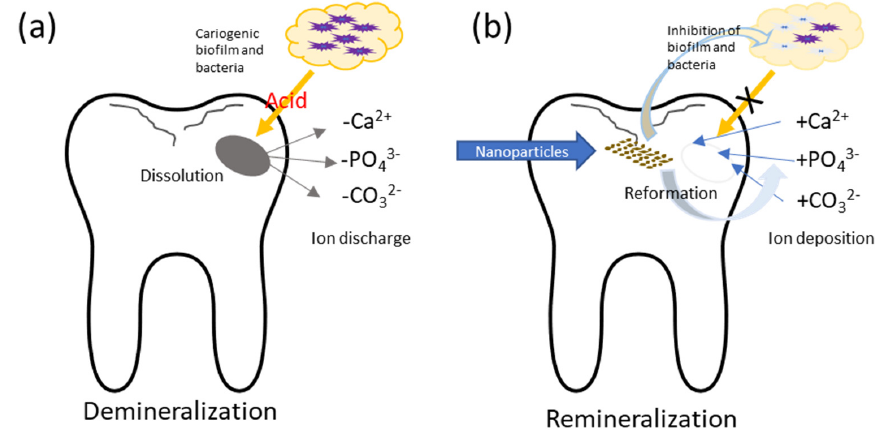
Figure 1. Mechanism of ( a ) demineralisation and ( b ) remineralisation of the tooth